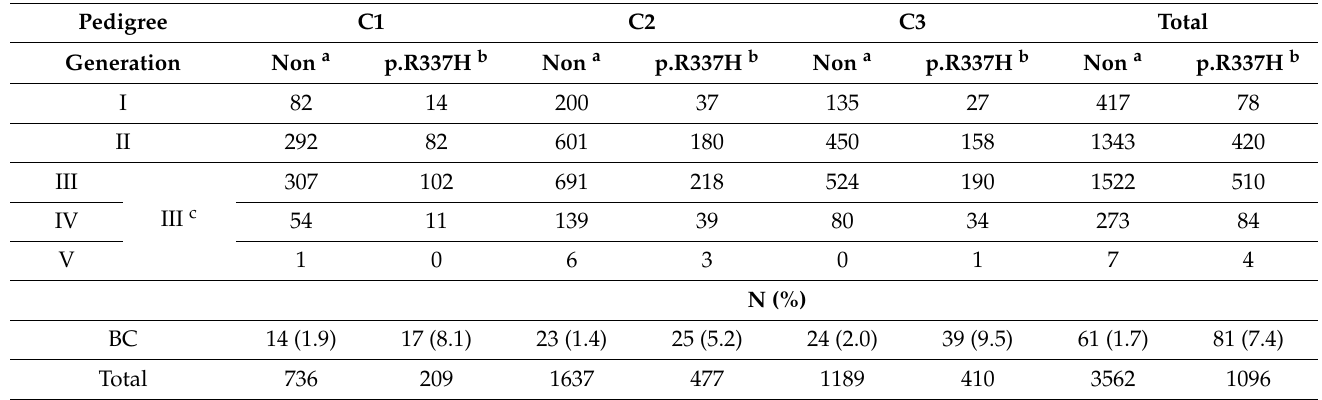
Table 1. Distribution of p.R337H noncarrier ( n = 3562) and p.R337H carrier women ( n = 1096) and BC (30+ years old) in the three subregions (C1, C2, and C3) of Paran á state and according to their position in the